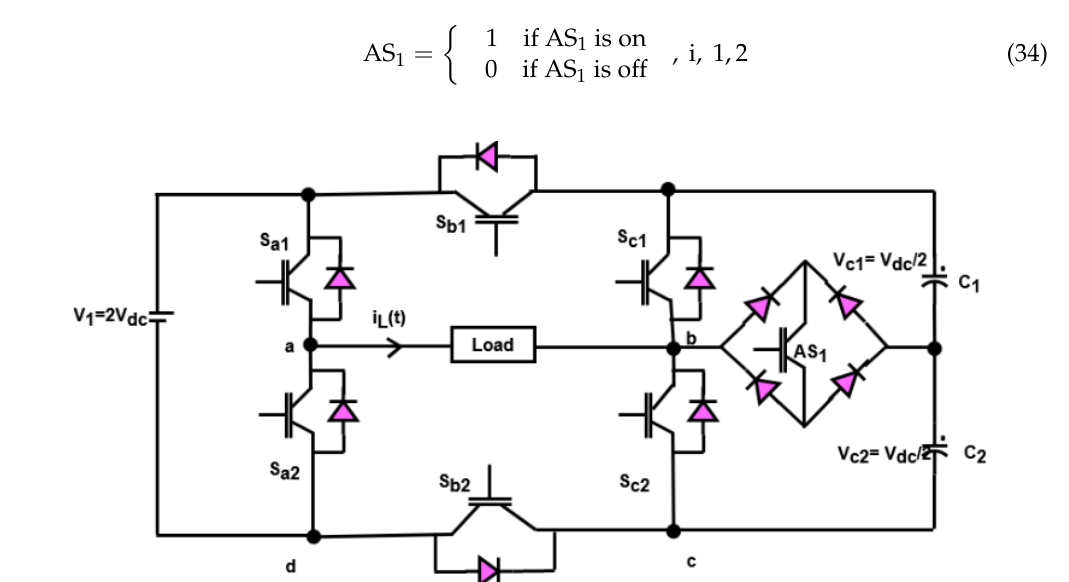
Figure 7. Equivalent circuit model of nine-level inverter. Table 1. Switching states of